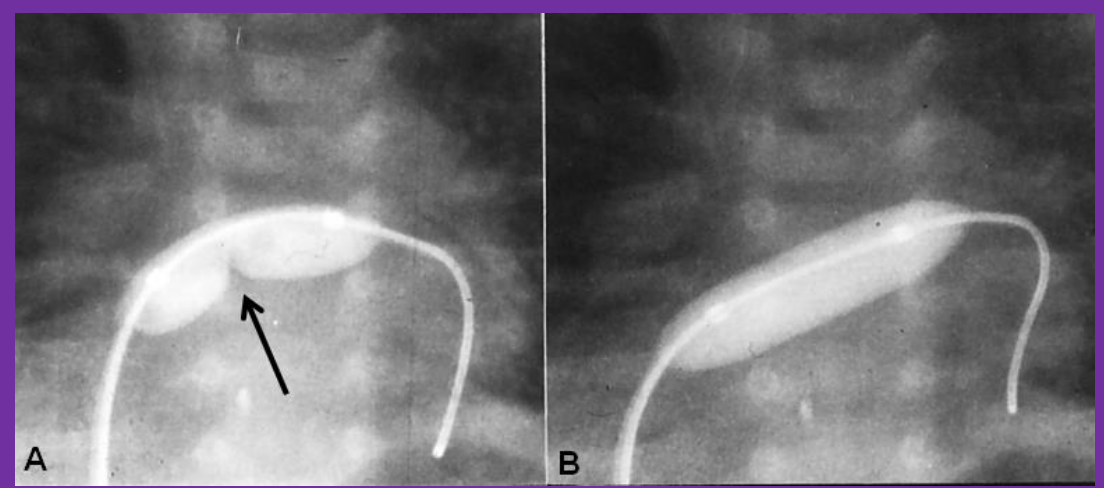
Figure 4. Selected cine frames of a static balloon angioplasty procedure to enlarge a restrictive patent foramen ovale, illustrating an inflated balloon in the posterior-anterior ( A ) view, displaying waisting of the balloon (arrow in ( A )) which was fully abolished following further inflation of the balloon ( B ). Modified from [7].